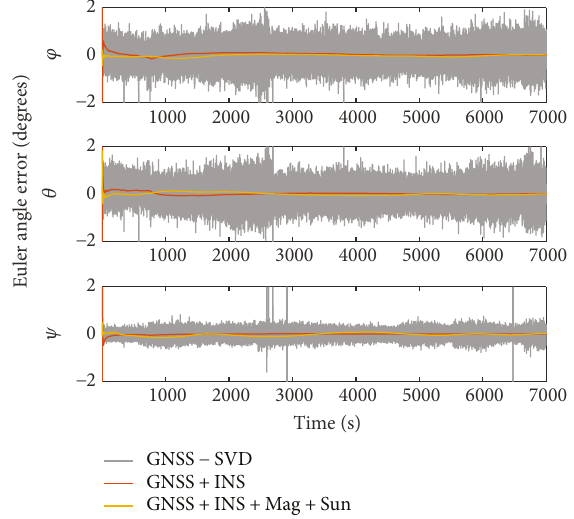
Figure 8: Roll, pitch, and heading errors for multisensor fi lter in GNSS + INS mode, GNSS+ INS +Mag+SS mode, with GNSS-only result for comparison. This fi gure has been reproduced from the conference paper version of this work